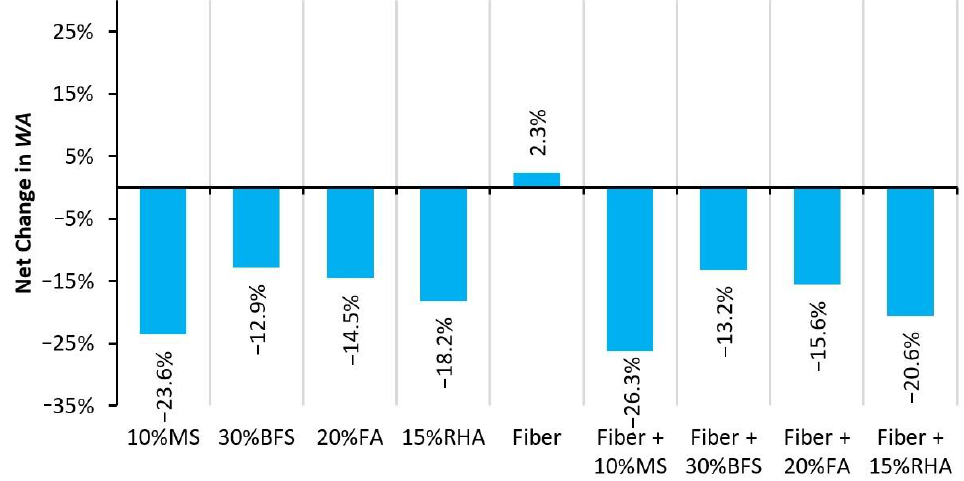
Figure 19. Net change in WA due to the addition of fibers and mineral admixtures.